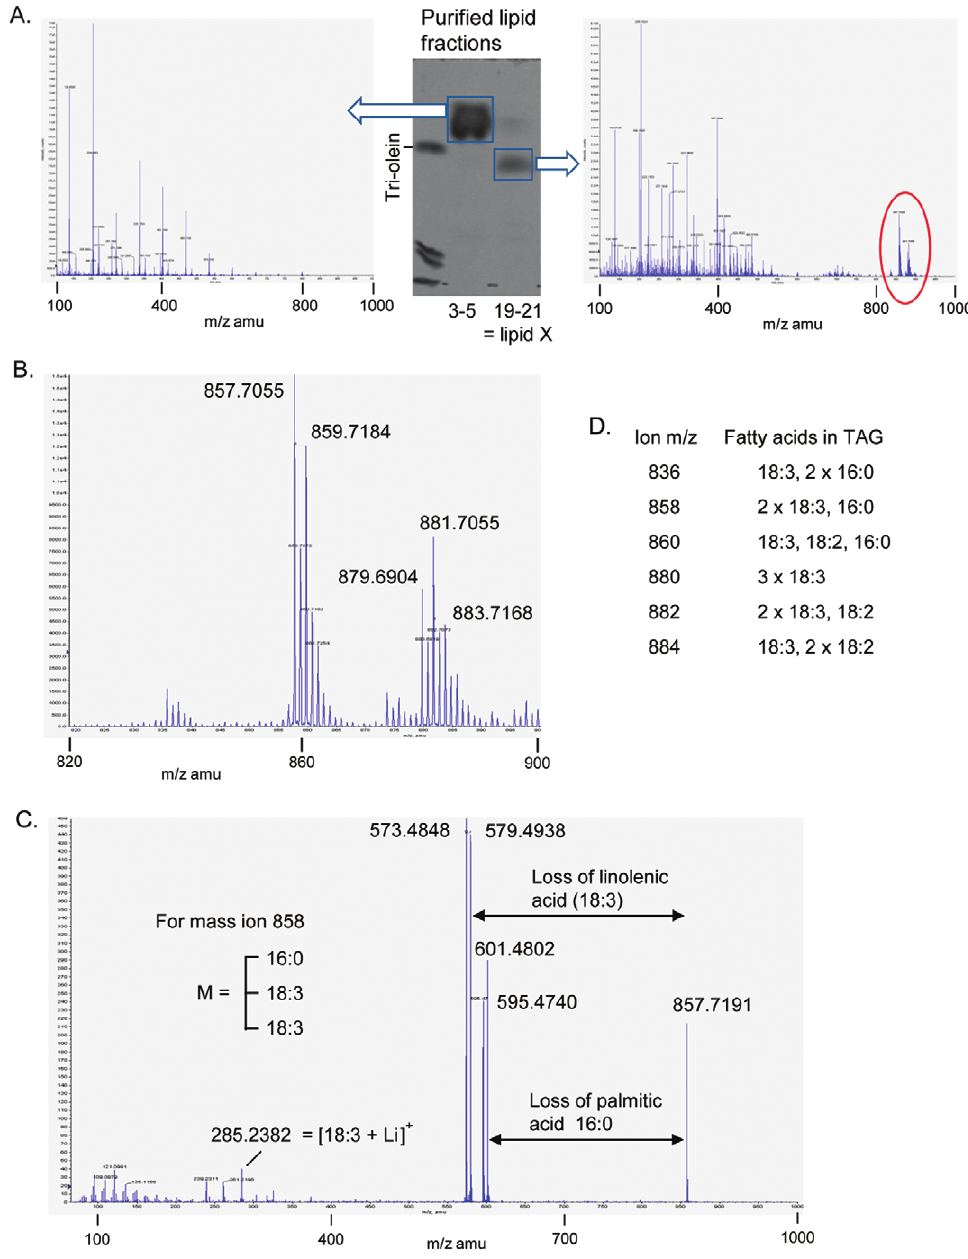
Figure 4. MS analysis of purified neutral lipids from pollen. Purified neutral lipids from pollen were analysed by TLC and used for electrospray MS analysis in the presence of lithium (panel A). Ions between 830 and 900 amu in the lipid X fraction (highlighted in red and Panel B) were selected for fragmentation and the diagnostic fragments produced, such as those in Panel C from the 858 mass ion, allowed determination of fatty acid composition of proposed TAG species (Panel D).